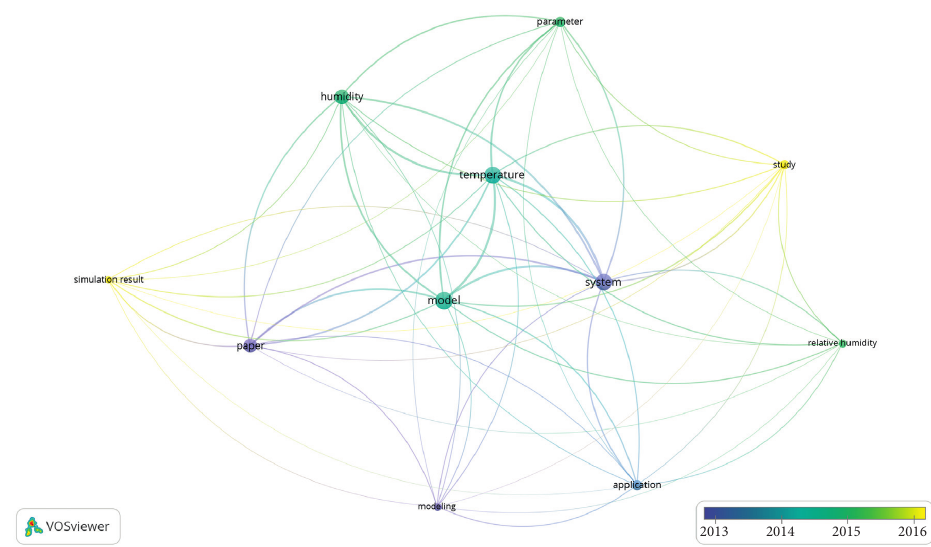
Figure 3: Title and abstract co-occurrence map